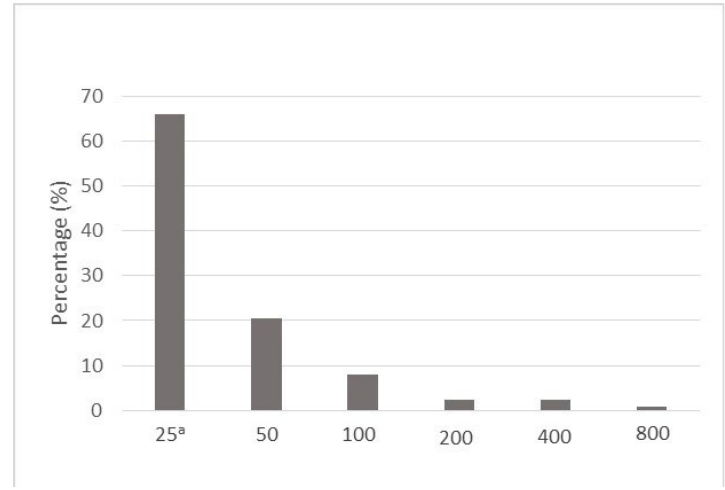
Figure 1. Distribution of Toxoplasma gondii antibody levels in seropositive slaughter pigs in Serbia. a Reciprocal of titre.